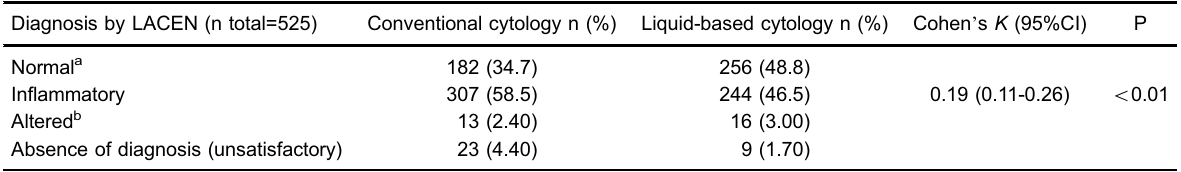
Table 2. Comparison of the diagnostic interpretations evaluated by LACEN of 525 patients obtained through conventional cytology evaluation and liquid-based ThinPrep evaluation in the State of Pernambuco, 2011. Diagnosis by LACEN (n total=525)